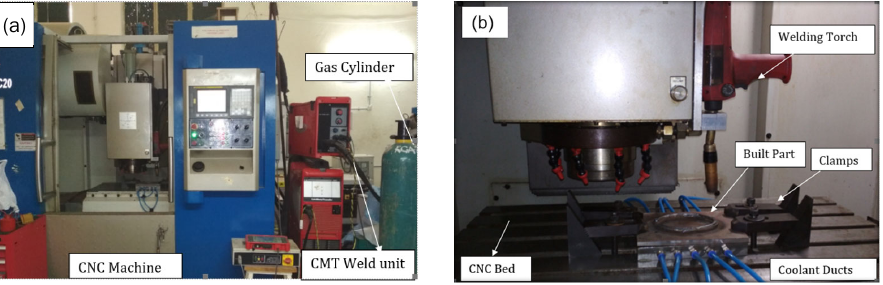
Figure 1. ( a ) Experimental setup showing the CNC machine and the weld-deposition unit; ( b ) Weld-deposition unit mounted on the CNC’s milling head.